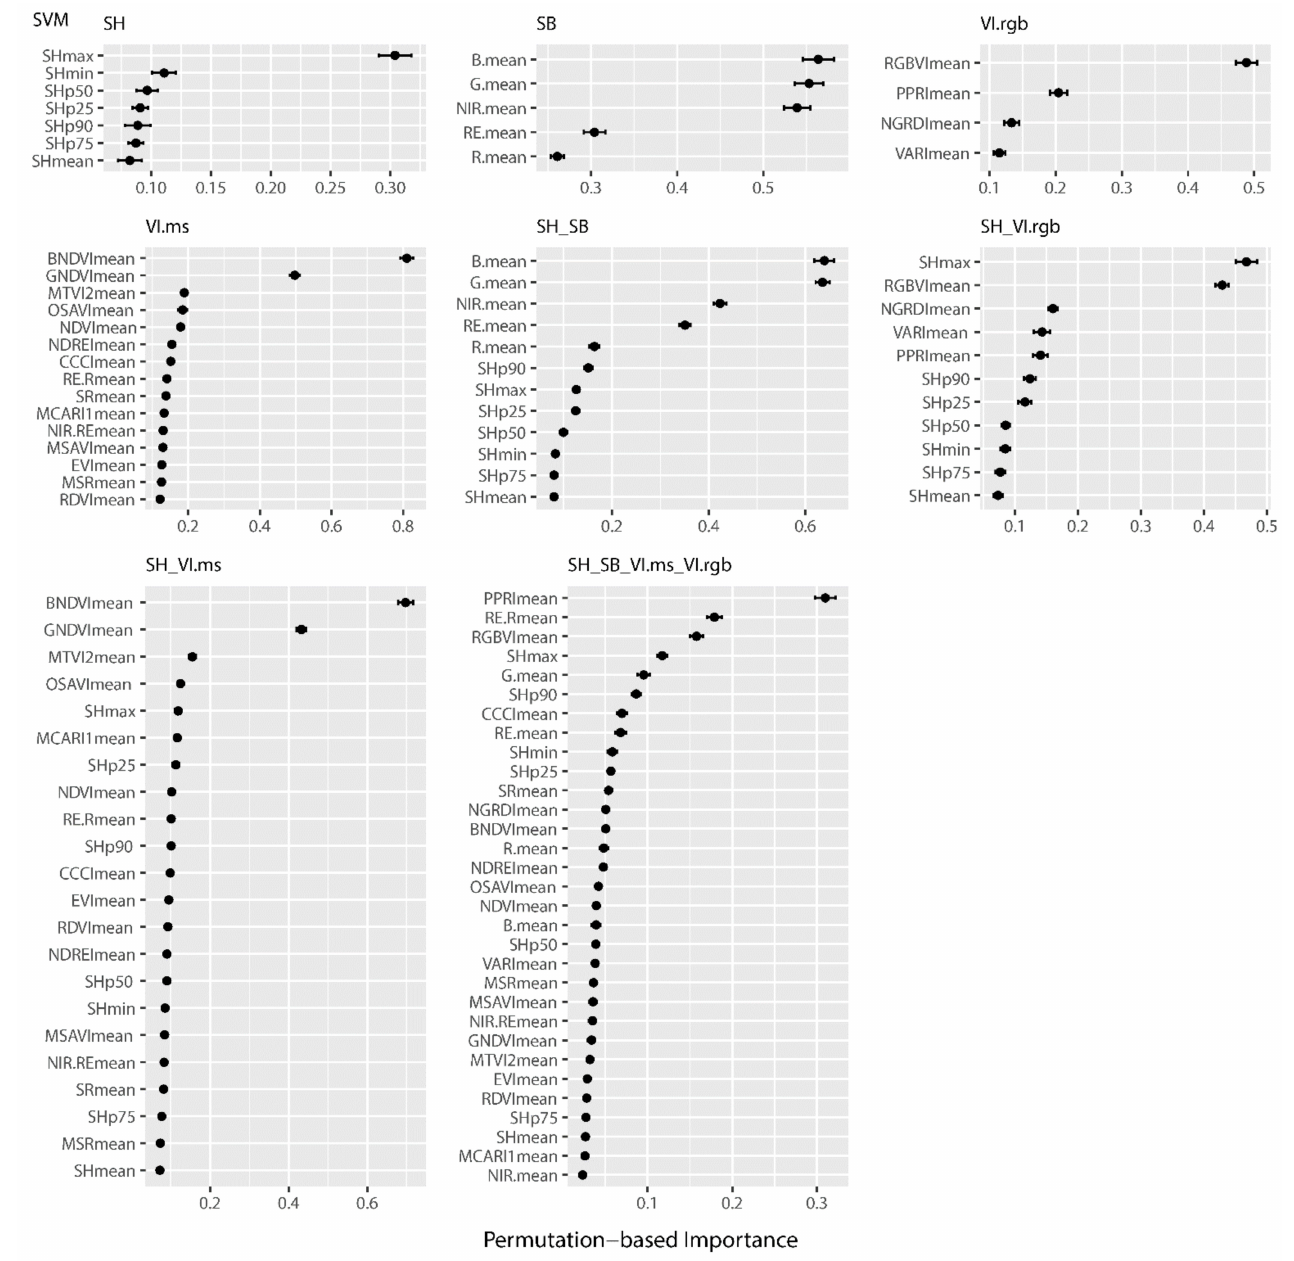
Figure A6. VIP of N% estimation with